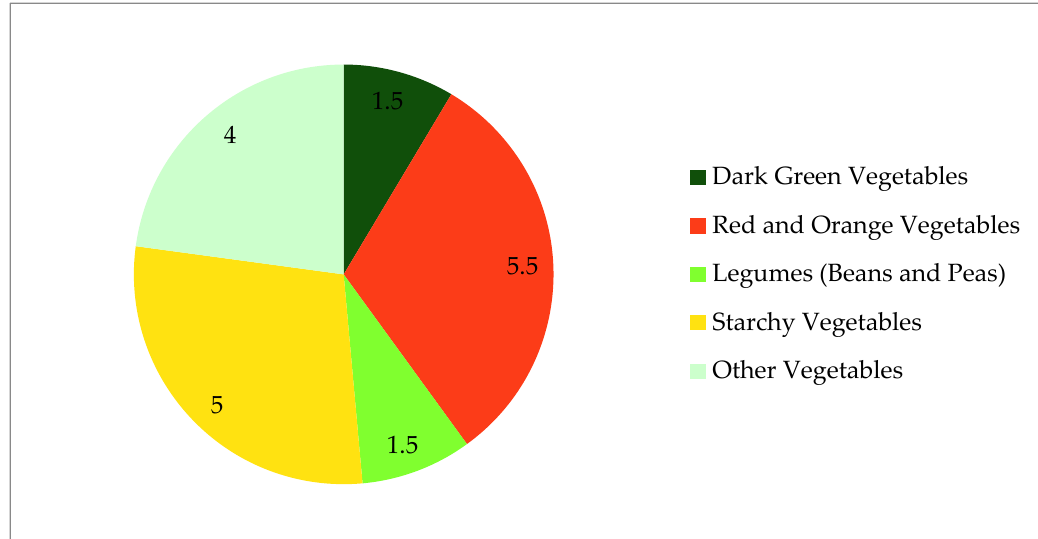
Figure 1. Composition of weekly vegetable variety recommendations (in cups), sum total 17.5 cups.